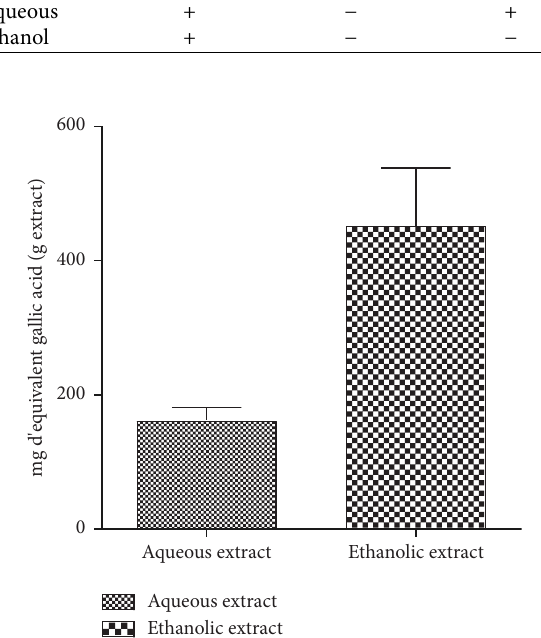
Figure 6: Total favonoid content of the aqueous and ethanol extracts.